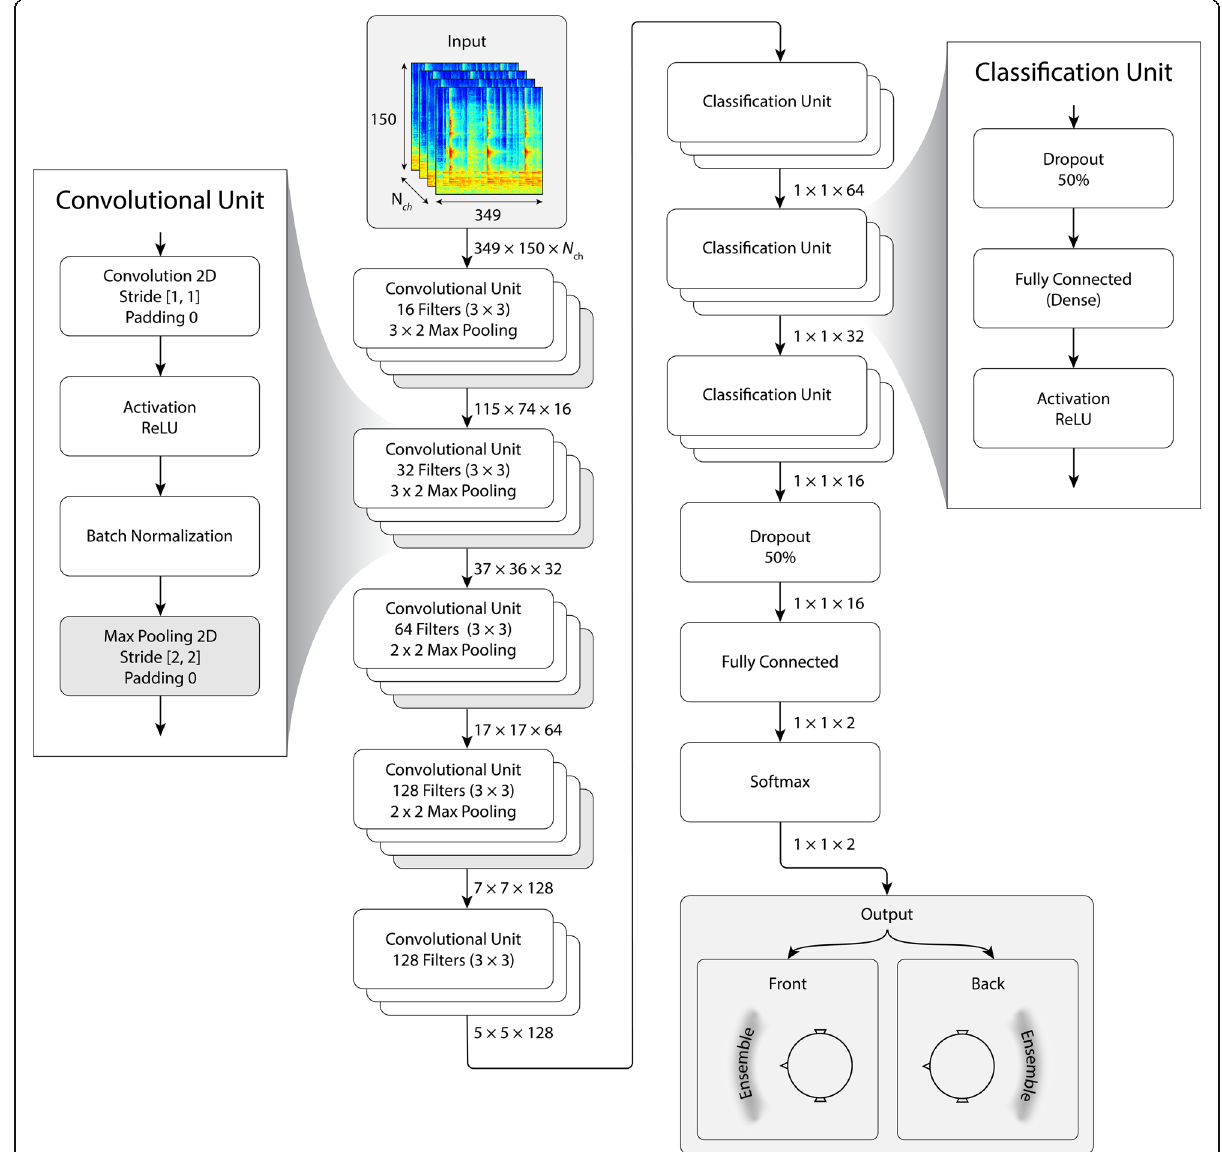
Fig. 9 CNN topology used for the discrimination of front and back ensemble